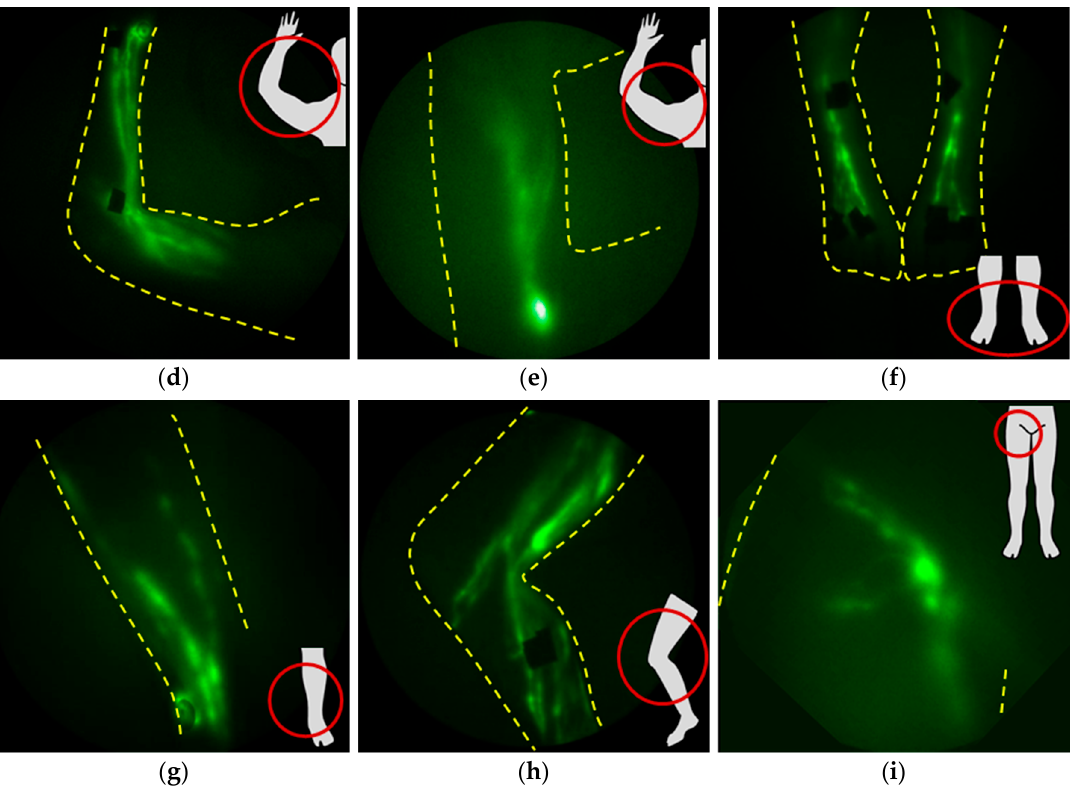
Figure 4. Typical NIRF-LI images of normal lymphatics in the upper and lower extremities including the ( a ) dorsum of the hand, ( b ) dorsal and ( c ) volar forearms, ( d ) medial arm, ( e ) axillary nodes, ( f ) dorsum of the feet, ( g ) medial ankle, ( h ) medial calf and knee, and ( i ) inguinal basin. Injection sites are covered with round bandages and / or black vinyl tape. The brightness and contrast of the images have been adjusted to facilitate the visualization of the 16-bit imaging depth.